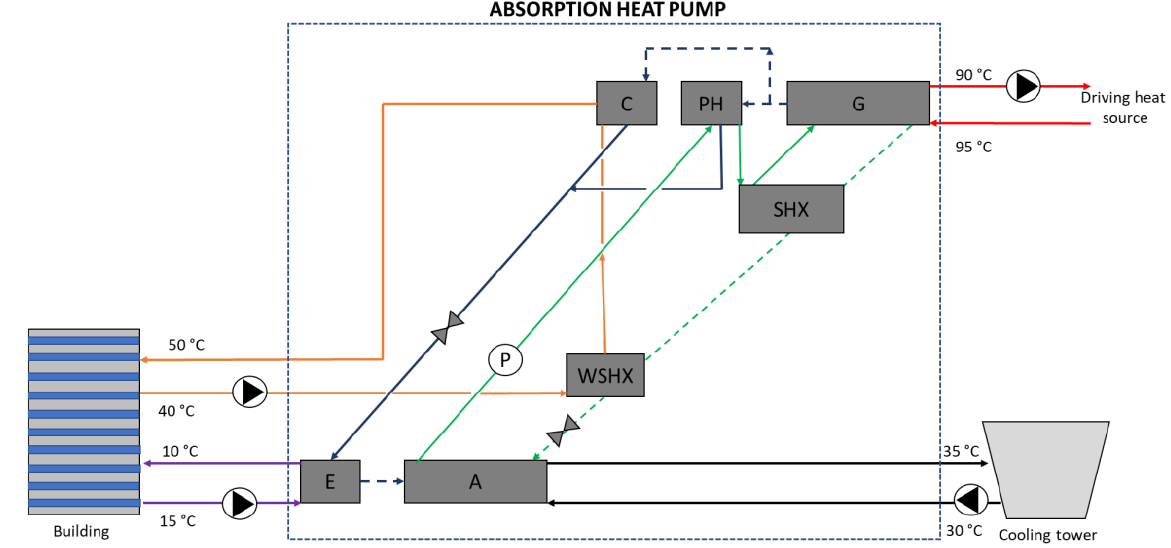
Figure 6. Layout for the simultaneous heating and cooling for air conditioning applications.